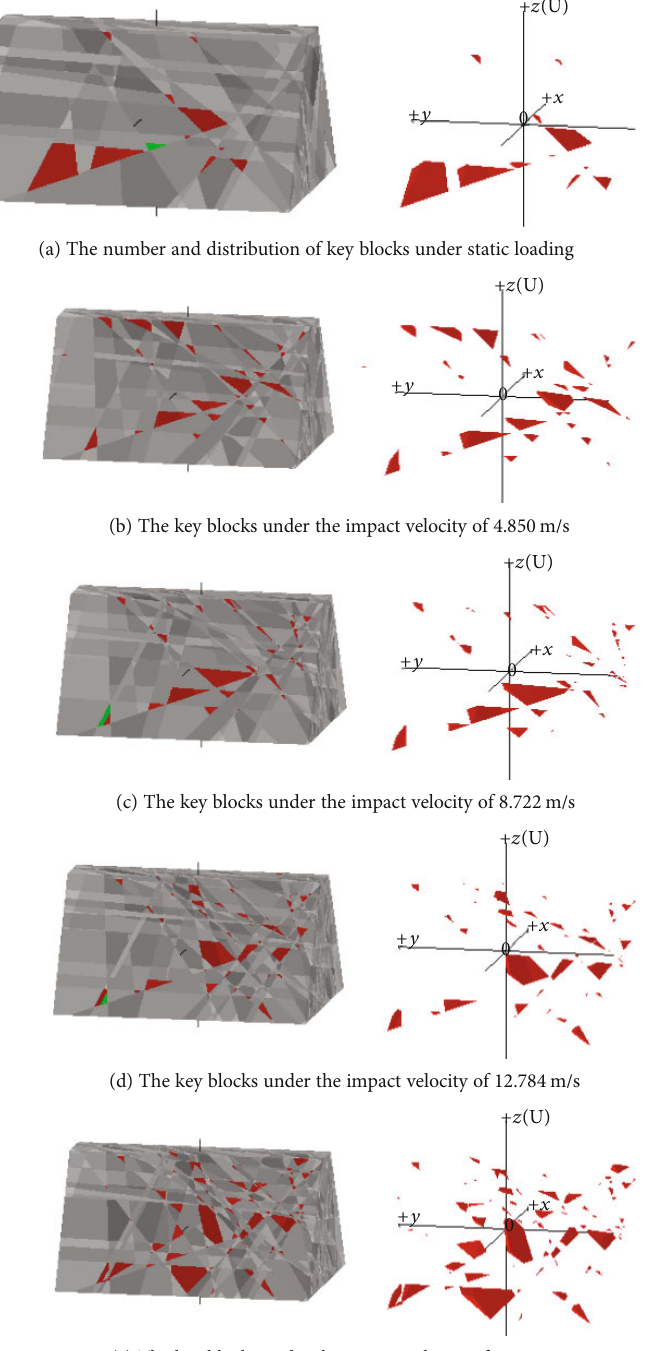
tively. Figure 10 revealed that the number of key blocks becomes more with the increase of impact velocity. Di ff erent impact velocities in the test and simulation represent di ff erent degrees of engineering disturbances on rock joints. After a series of theoretical study, experimental